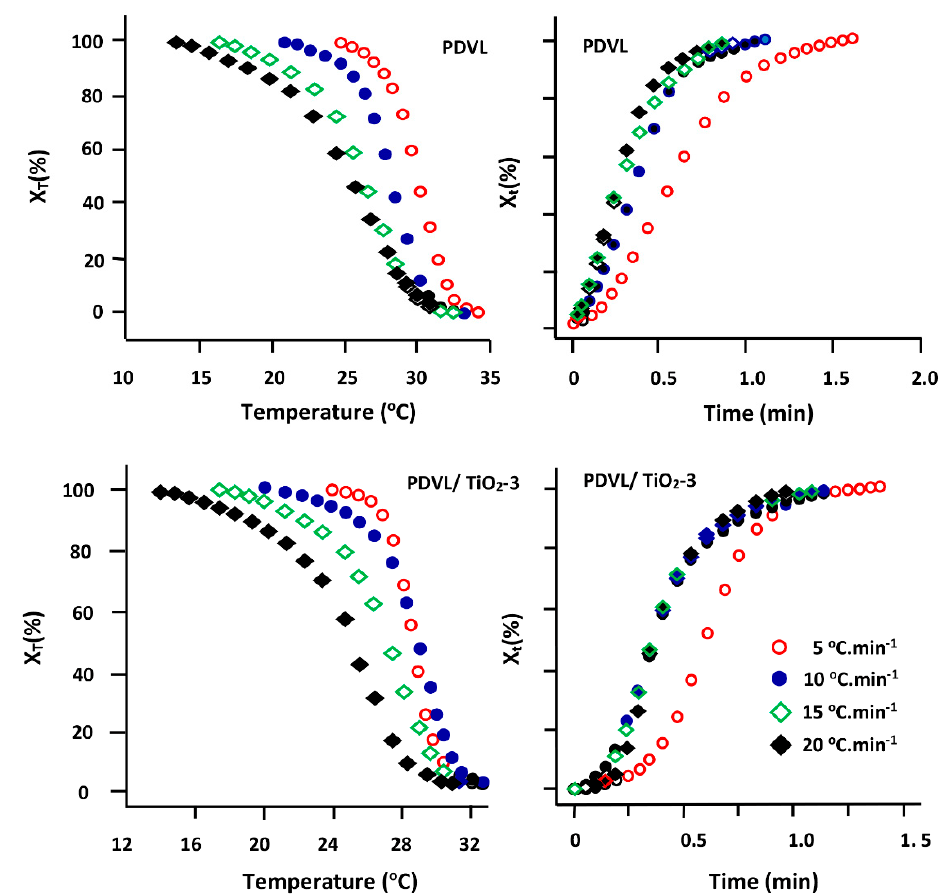
Figure 8. Sigmoid plots indicating the variation of the relative crystallization degree X T and X t for pure PDVL and the PDVL/TiO 2 -3 nanocomposite versus temperature and time, respectively.